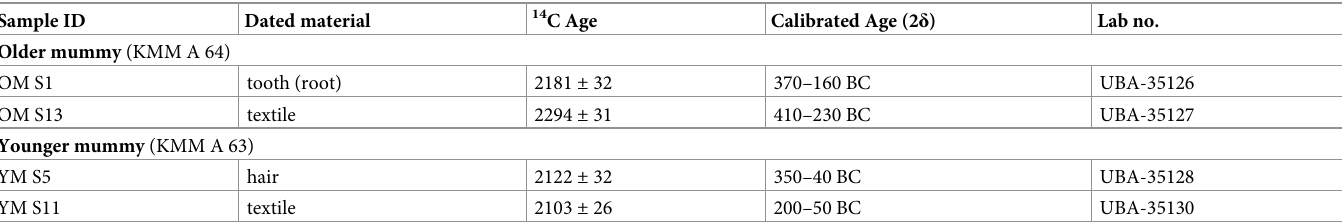
Table 2. AMS dates from the mummies. The AMS dates were calibrated with the OxCal 4.3.2 [15], using the IntCal13 calibration curve [16] and rounded by ten. Sample ID